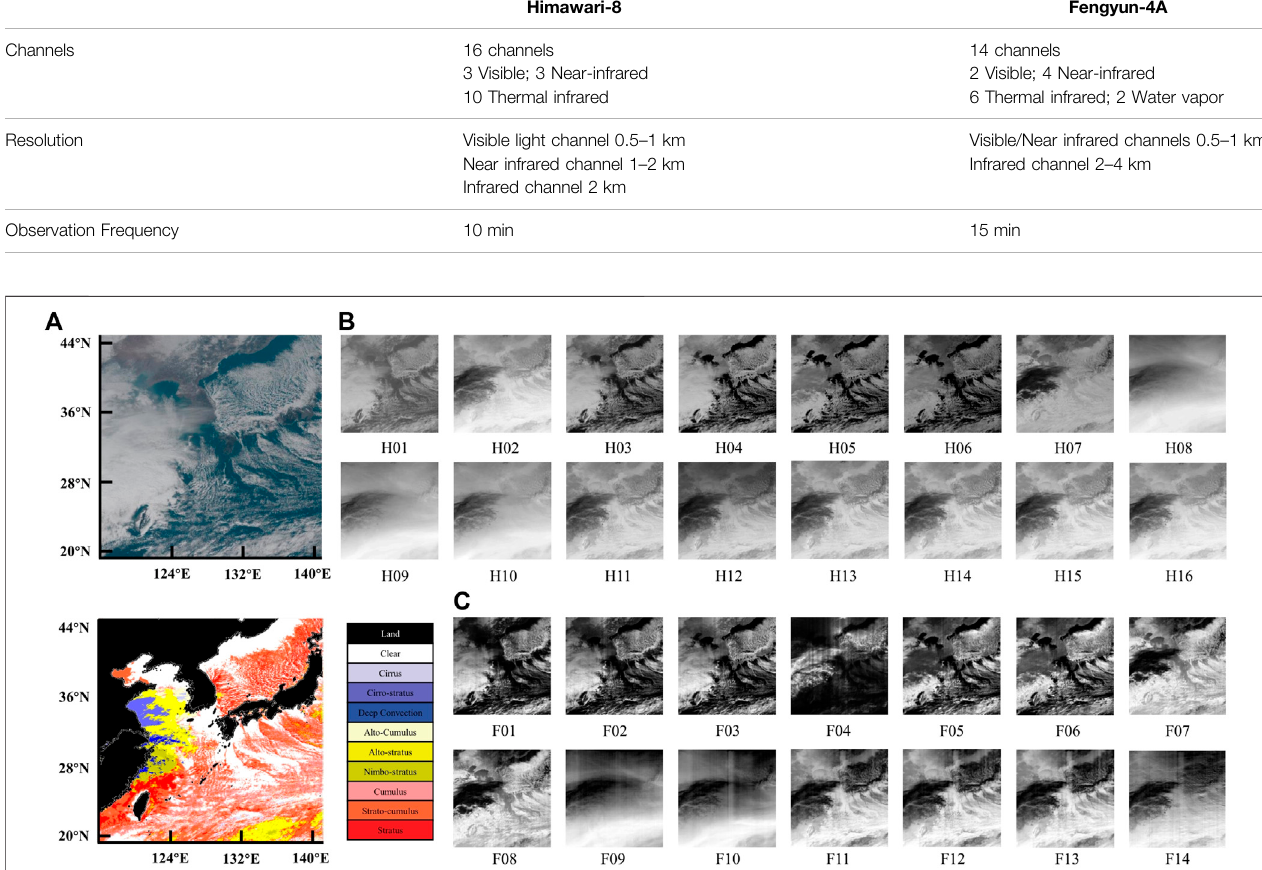
Frontiers in Earth Science |